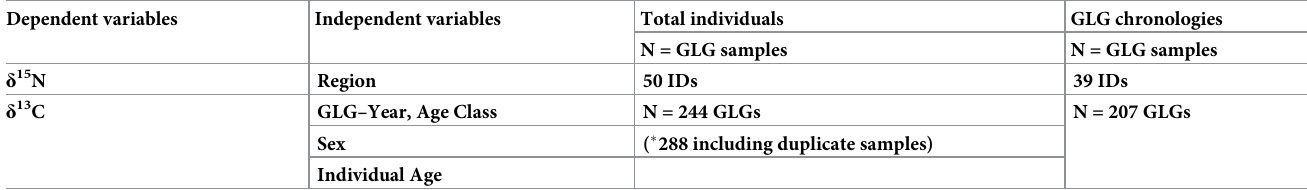
Table 1. Data structure, variables and sample